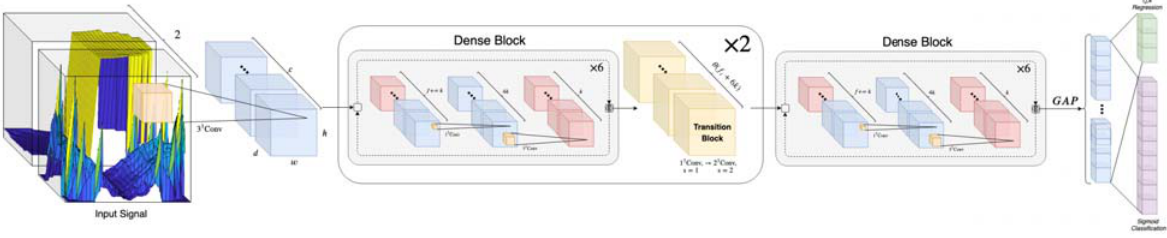
Fig. 2 The proposed 3D DenseNet architecture, comprised of 3 dense blocks each containing 6 layers per block and growth rate of k = 32 . Each unit in the output layer represents a classification perturbation type or source location ( i,j,k